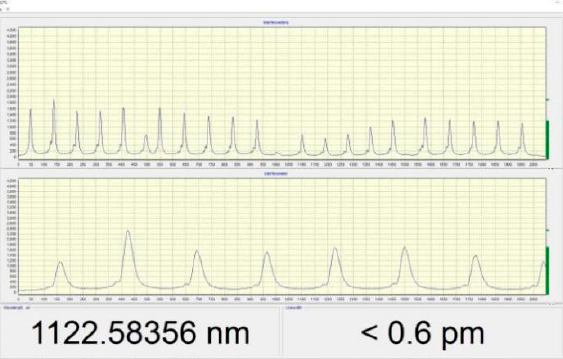
Figure 4. The longitudinal mode characteristic of the 1123 nm laser at 7.65 W incident pump power.